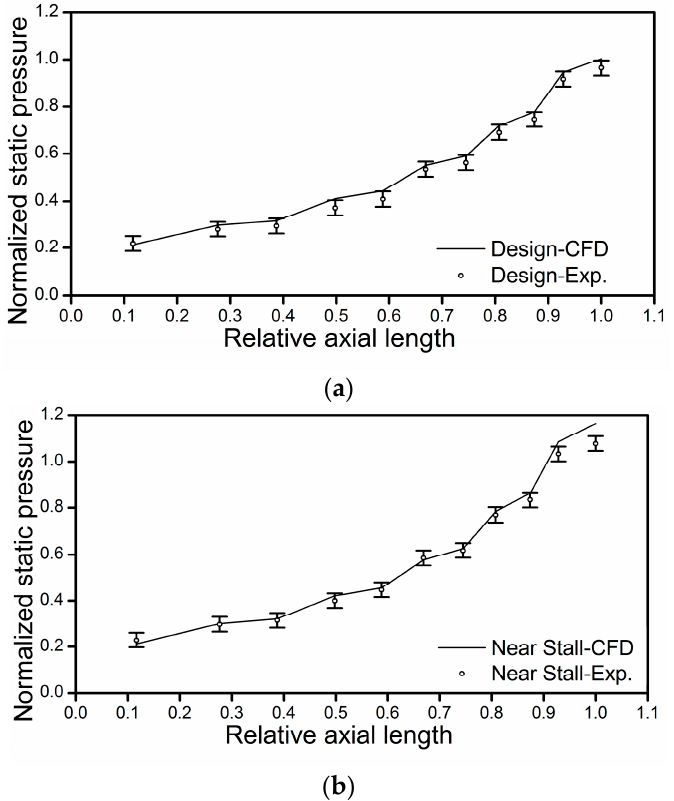
Figure 5. Measured and predicted casing static pressure. ( a ) Design point; ( b ) Near stall point. Exp.: Experiment.